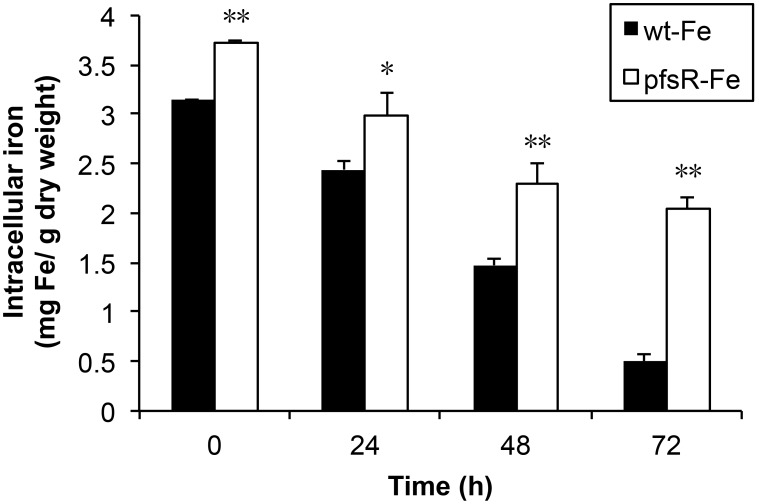
Intracellular iron content of the wild type and the pfsR deletion mutant.Iron content in wild-type (black columns) and pfsR deletion mutant (white columns) cells before (0 h) or after (24 h, 48 h, and 72 h) exposure to iron limitation was measured using atomic absorption spectroscopy. Iron content is expressed as milligram iron per gram dry cell weight. Data (means±SD) are based on two independent experiments with three atomic absorption replicates each. A single asterisk and double asterisks indicate significant difference between wild type and the pfsR deletion mutant at P<0.05 and P<0.01 levels, respectively (student’s t-test).